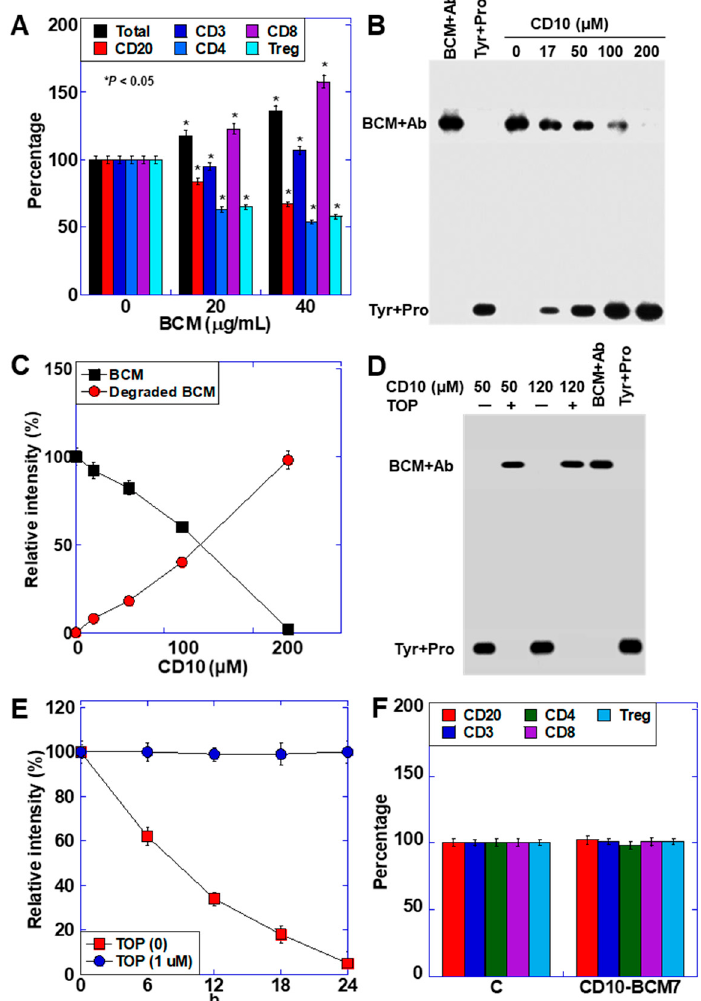
Figure 1. Effect of BCM on spleen cells and degradation of BCM by CD10. ( A ) Effect of BCM on subpopulations of spleen cells. Spleen cells of BALB/c mice were treated with BCM (0.1 µ g/mL) [21] for 48 h. Differentiation markers were examined by ELISA. ( B ) Effect of CD10 on degradation of BCM. 125 I-labeled BCM (50 μ g) was incubated with CD10 for 16 h. Intact BCM bound to anti-BCM antibody and degraded peptides were separated with electrophoresis and detected by autoradiography. ( C ) CD10 concentration-dependent degradation of BCM demonstrated by semi-quantification of panel B. ( D ) Effect of TOP on BCM degradation by CD10. 125 I-labeled BCM (50 μ g) was incubated with CD10 and TOP (1 μ M). ( E ) Time course of degradation of BCM by CD10. 125 I-labeled BCM (50 μ g) was incubated with CD10 (60 μ g) and TOP (1 μ M). ( F ) Effect of degraded BCM on subset of spleen cells. Error bar, standard deviation from three independent trials. BCM, β -casomorphin-7; cluster of differentiation; ELISA, enzyme-linked immunosorbent assay; Treg, regulatory T cell; tyr-pro, 1st and 2nd amino acids of BCM; Ab, anti-BCM antibody; TOP, thiorphan.